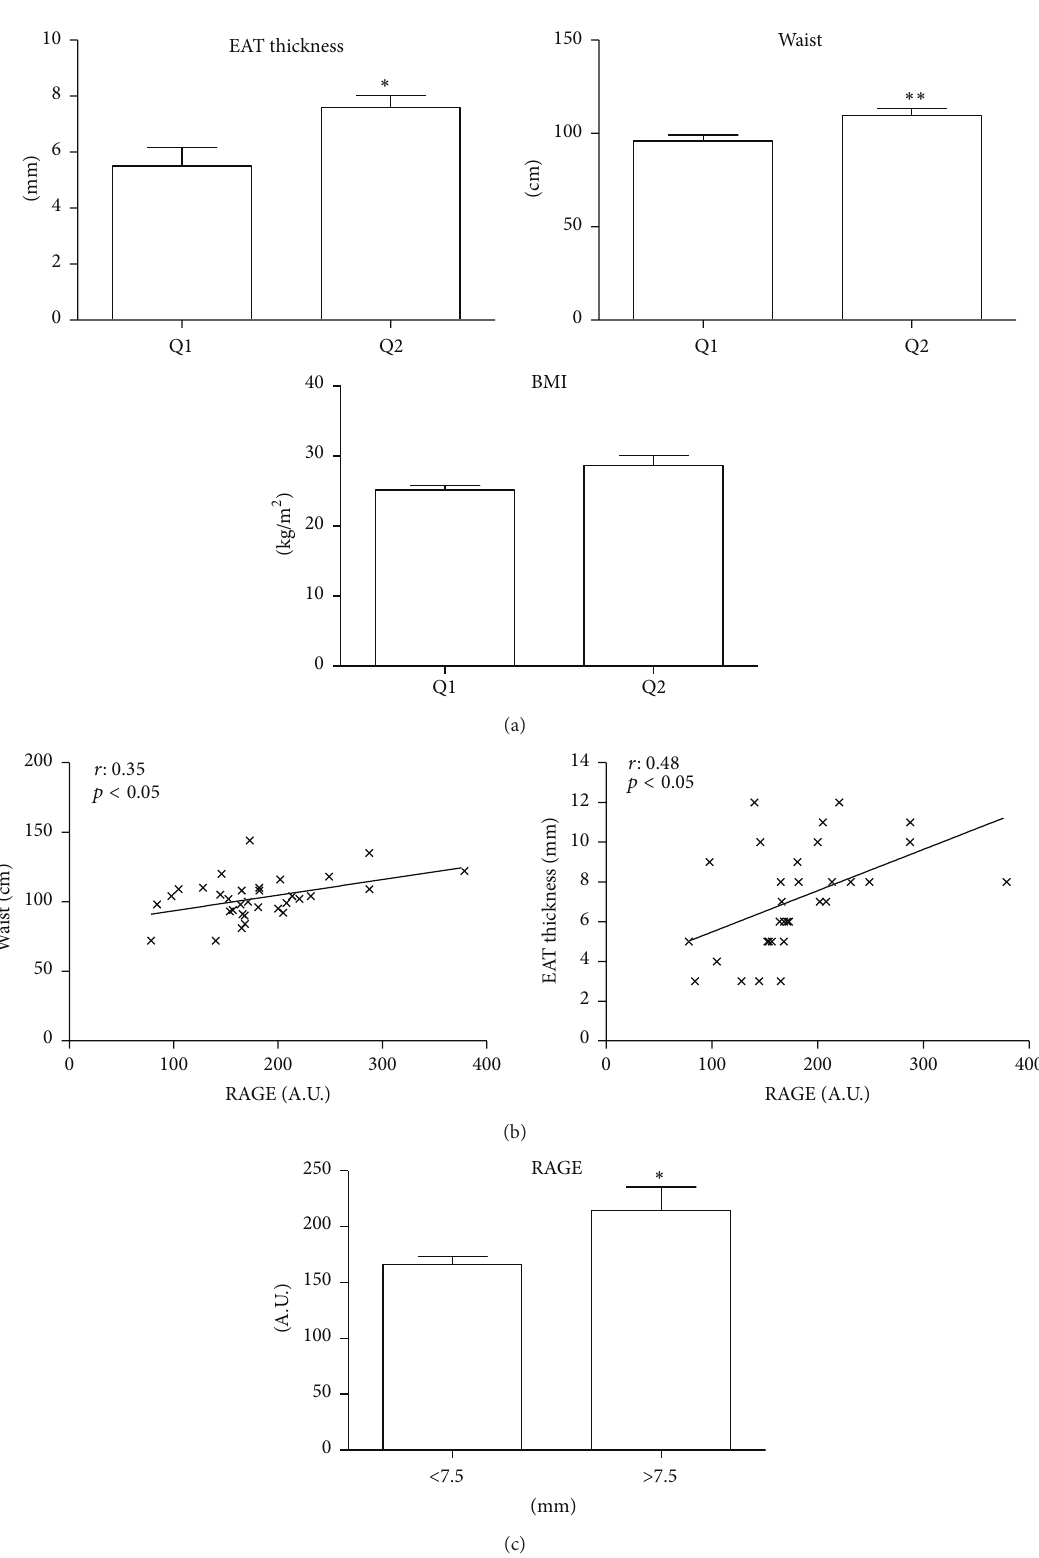
Figure 1: Relationship between RAGE expression in EAT, EAT thickness, and anthropometric indices in CAD patients. (a) CAD patients were stratified into two groups (Q1 and Q2) on the basis of the median RAGE expression in EAT, and EAT thickness, waist circumference, and BMI were compared in the two groups. (b) Spearman correlation analysis between mRNA RAGE level in EAT and waist circumference and EAT thickness. (c) CAD patients were stratified into two groups (Q1 and Q2) on the basis of the median EAT thickness (7.5mm) and the levels of RAGE expression were compared in the two groups. A.U.: arbitrary unit. Data are expressed as mean ± SD; ∗ 𝑝 < 0.05 , ∗∗ 𝑝 < 0.01